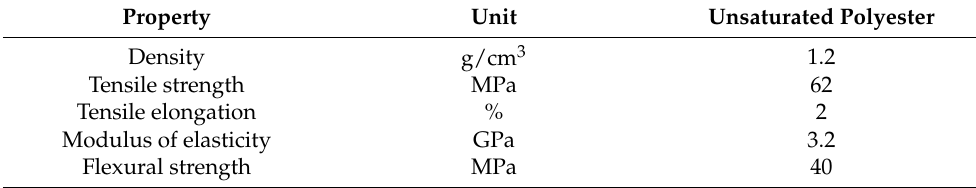
Table 2. Properties of Unsaturated Polyester.